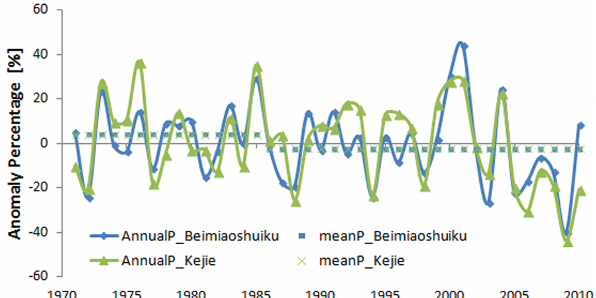
Figure 8. The inter-annual variability of annual rainfall recordings at two stations (Beimiaoshuiku and Kejie from 1971 to 2010). Note: Annual P represents the annual rainfall and mean P the average an- nual rainfall for the two periods.